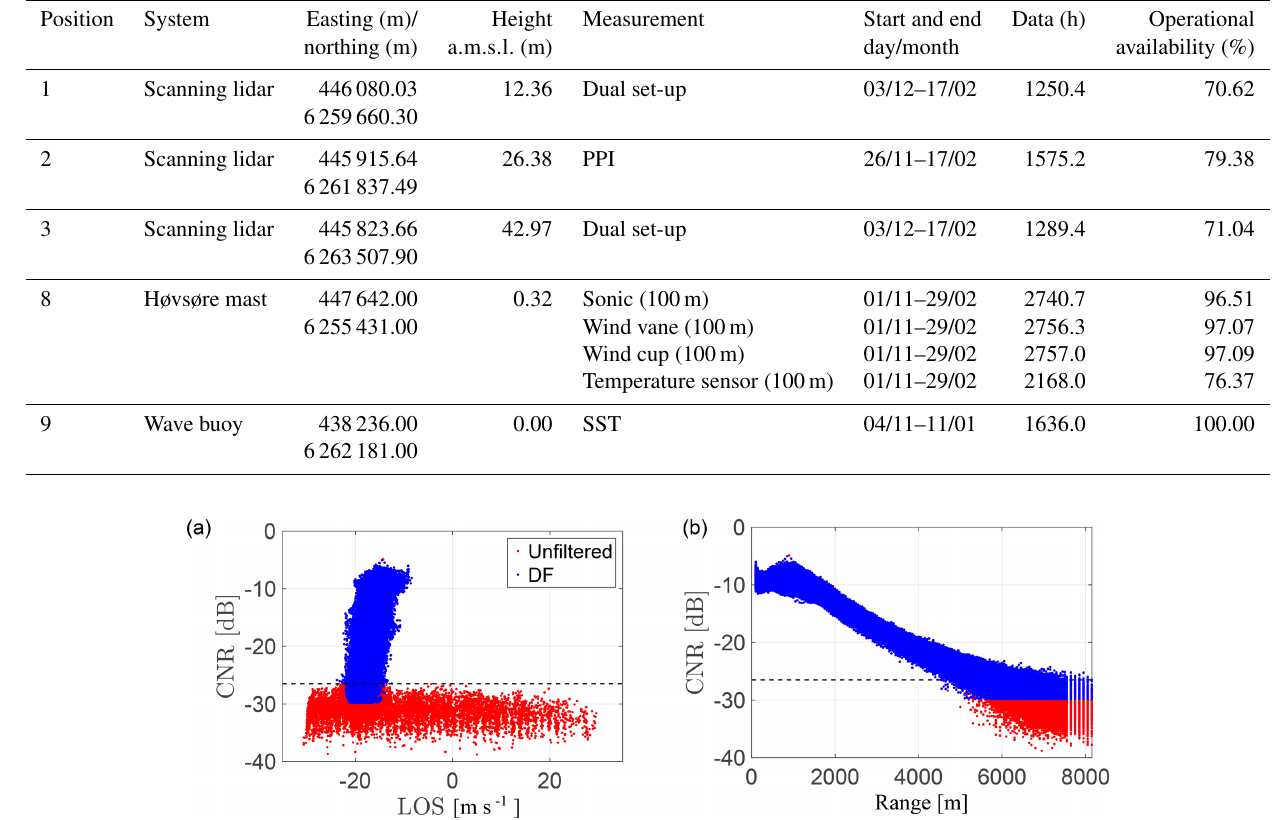
Table 1. Measurement periods, positions and operational availability for all of the systems used in the analysis.